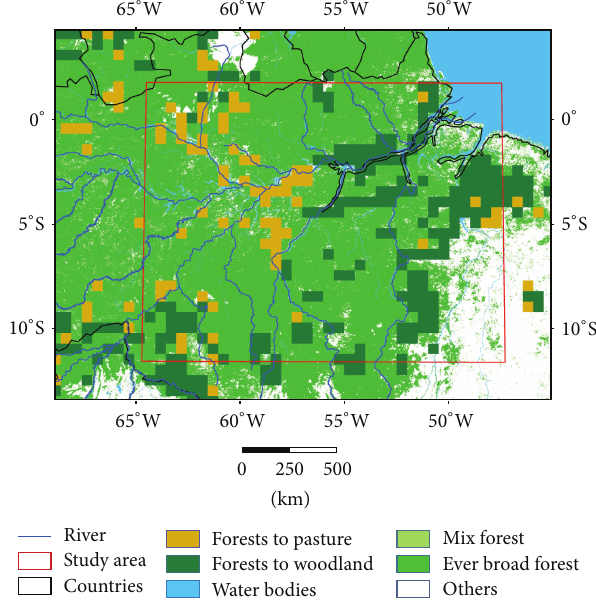
Figure 1: The land surface properties in Brazilian Amazon. Only forests and water bodies are shown in the land cover layer ( 1 km × 1 km, USGS land cover classification). Grid cells in which forests are converted into the pasture (yellow) and woodland (darkgreen) are provided in the land surface change layer (0.5 ∘ × 0.5 ∘ ) . The study area (red rectangle) covers most changed forest land